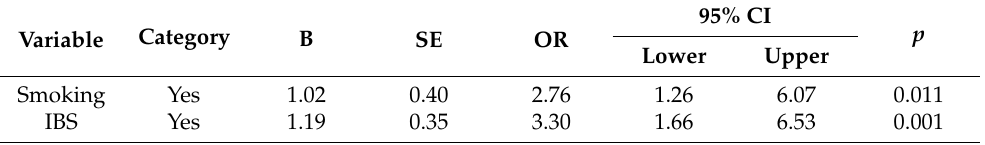
Table 5. Factors affecting insomnia prevalence among the participants ( n =